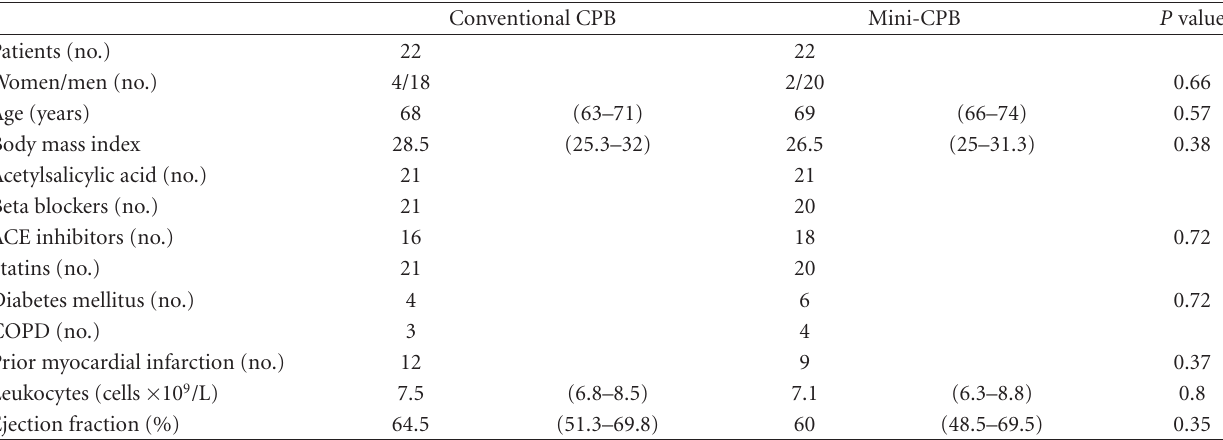
Table 1: Demographic and preoperative